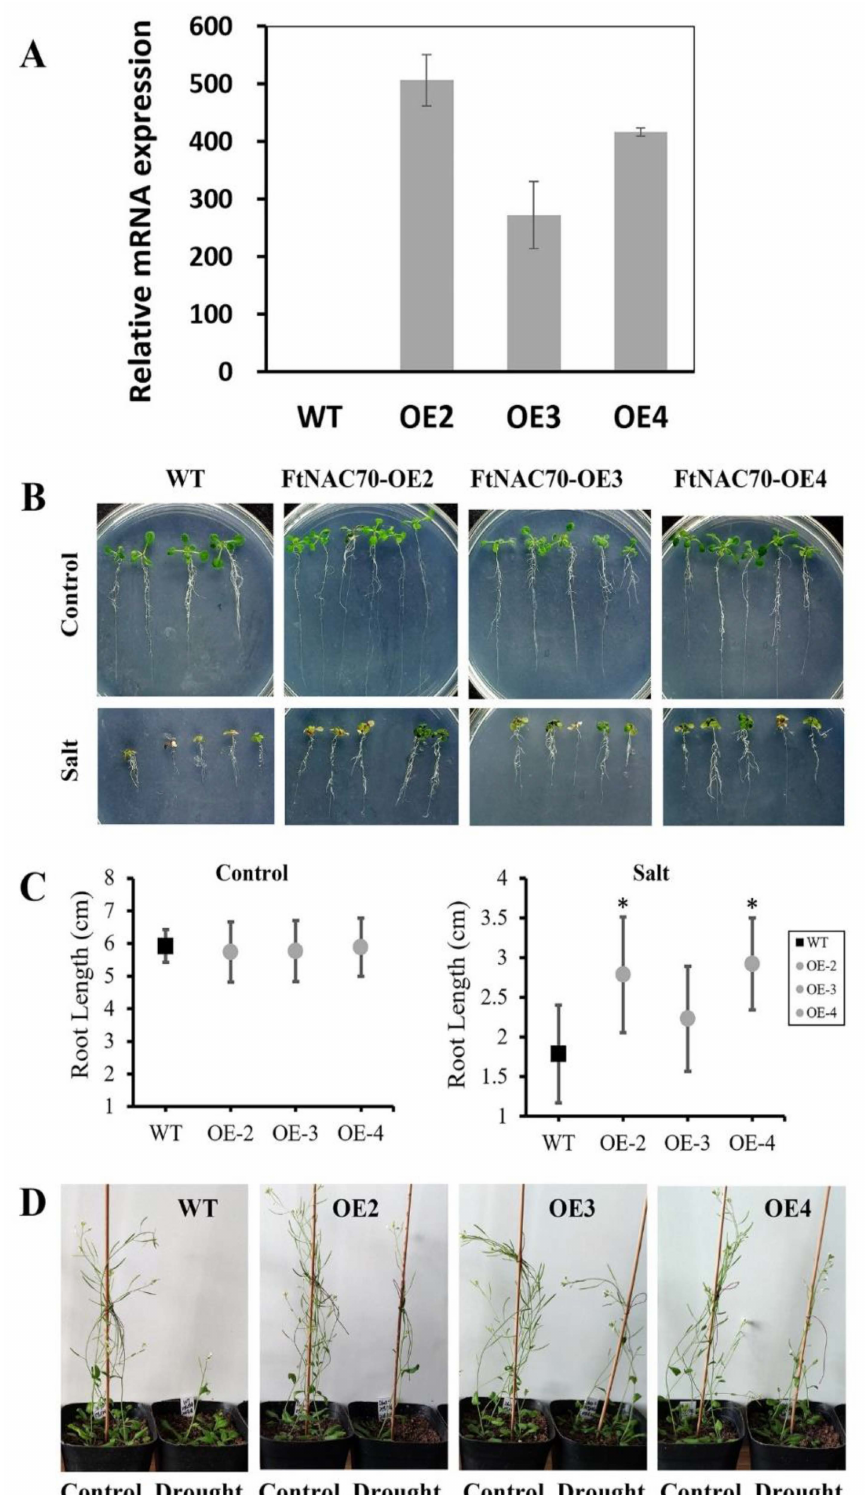
Figure 6. The effects of FtNAC70 on salt and drought. ( A ) Expression level of FtNAC70 in WT and three transgenic Arabidopsis lines ( FtNAC70 -OE2, FtNAC70 -OE3, and FtNAC70 -OE4). ( B ) Phenotype of the effect of FtNAC70 on salt stress. ( C ) Root length statistics of FtNAC70 on salt stress. ( D ) Phenotype of the effect of FtNAC70 on drought stress. The error bars indicate the standard deviations of the replicates. Asterisks show the statistical significance evaluated by Student’s t